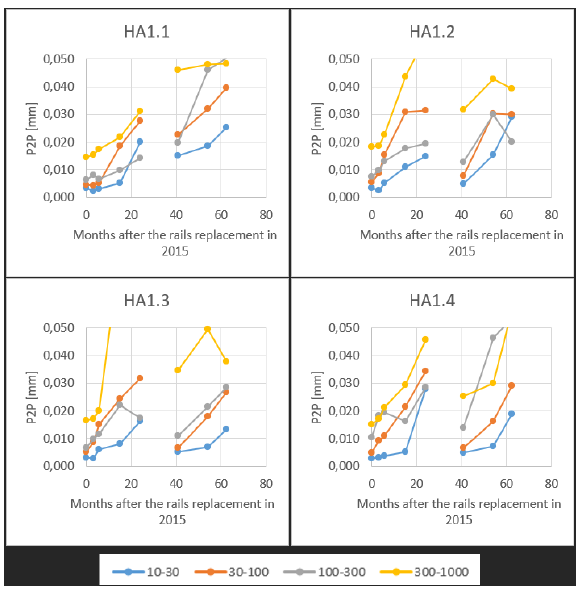
Figure 3. P2P progression in time for section Hady.